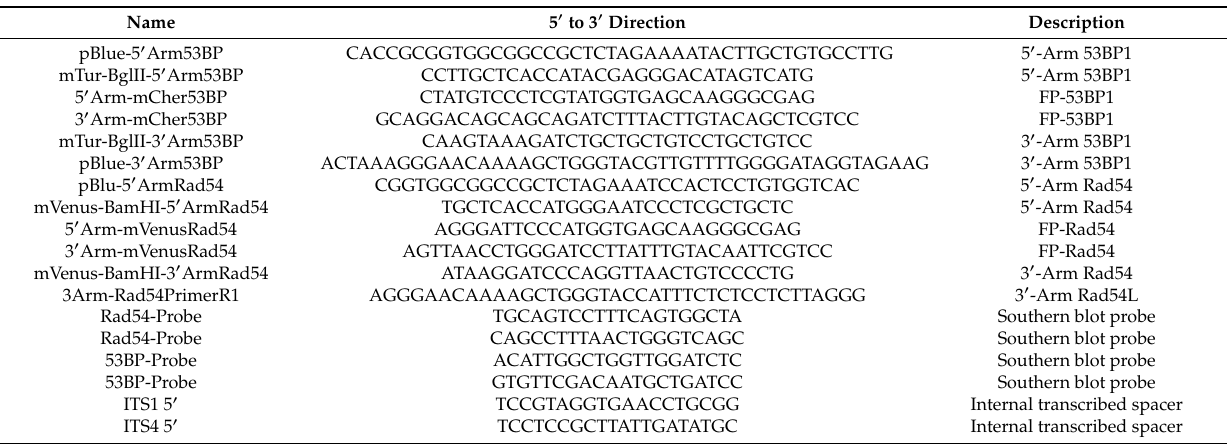
Figure 1. Construction of fluorescent biosensor clones. ( a ) mCherry was inserted at the C-terminus of 53BP1 . The non-targeted and targeted knockin of 53BP1 when the genomic DNA was cut with XbaI were 3.6 and 5.4 kbp. ( b ) For RAD54L , the non-targeted and targeted knockin when the genomic DNA was cut with SpeI and KpnI were 6.4 and 10 kbp. Codon regions are represented by boxes, and the gray-colored box is the last codon in each gene. The black triangle is the restriction site, and an open triangle denotes the stop codon. ( c ) Southern blotting of XbaI-digested (53BP1) and SpeI-KpnI-digested (RAD54L) genomic DNA. Definitions: mCherry, monomeric Cherry; mVenus, monomeric Venus; kbp, kilobase pair; 53BP1 , tumor protein p53 binding protein 1; RAD54L , DNA repair protein RAD54-like; WT, wild type. Table 1. List of primers used in this study.